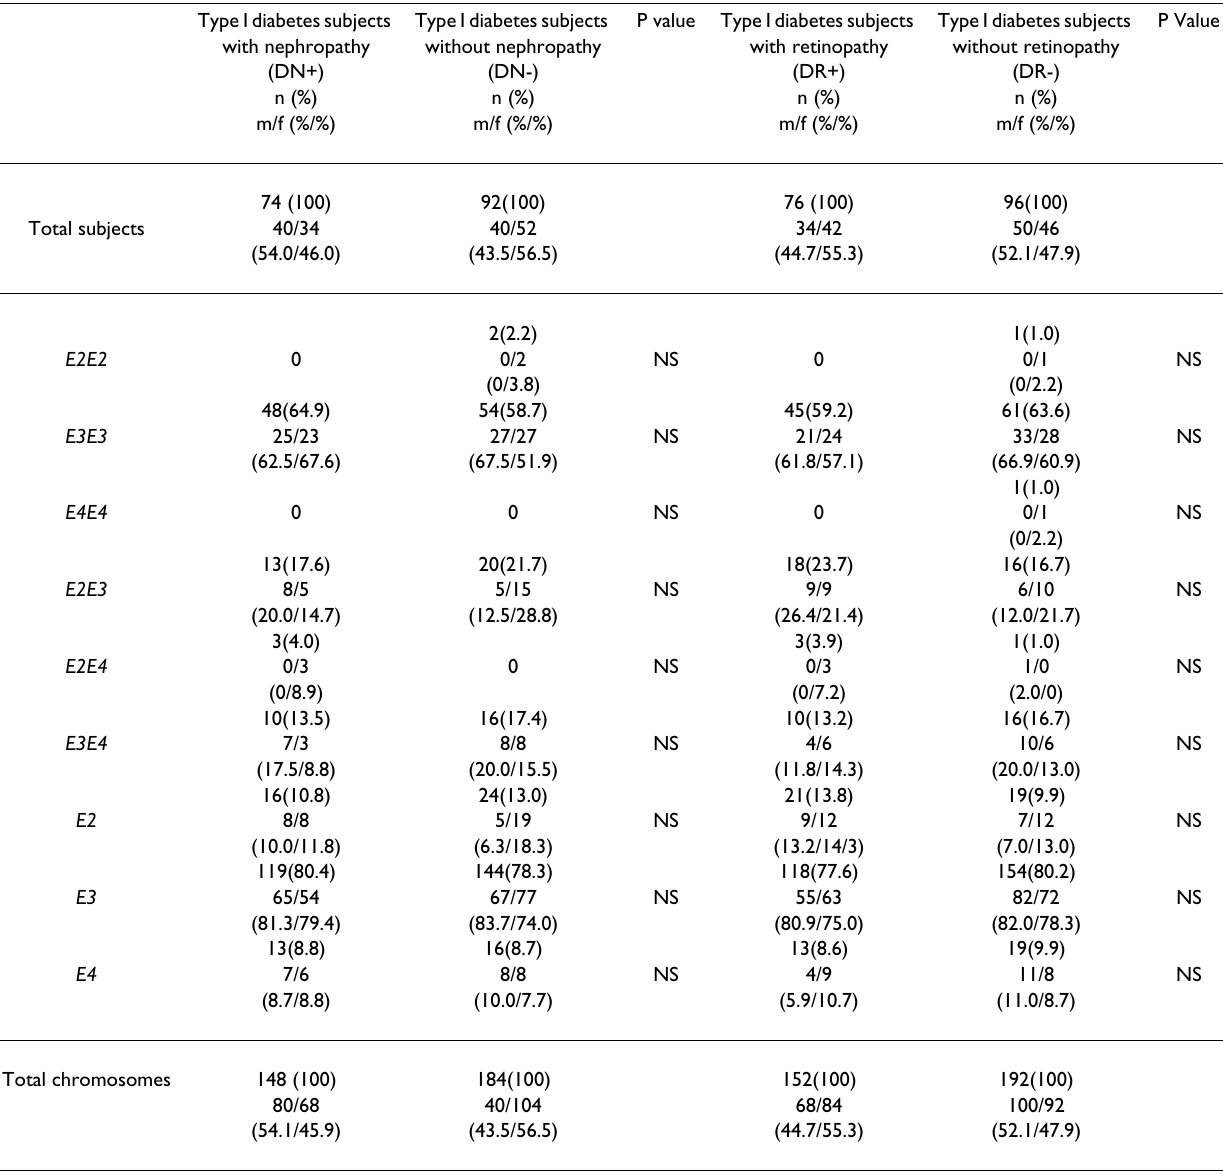
Table 2: Distribution of APOE genotypes and alleles in the case-control association